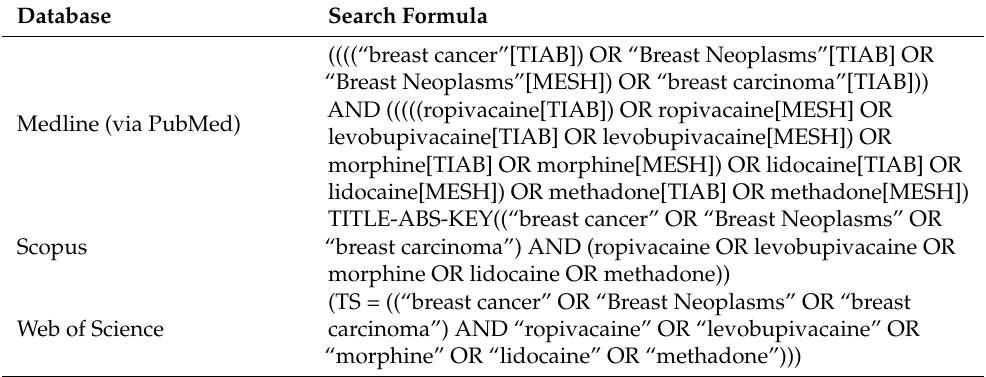
Table 3. Search Strategy